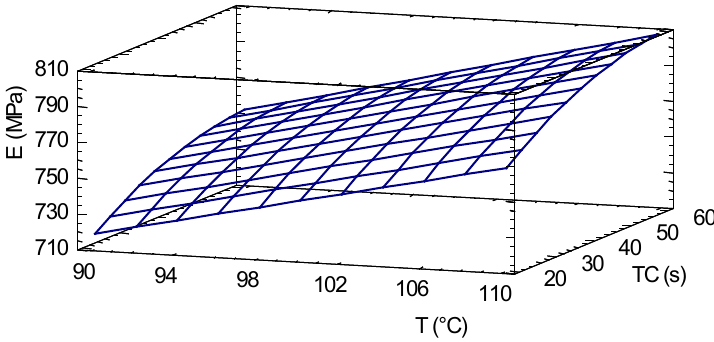
Figure 9. Estimated response surface for the modulus of elasticity considering the process temperature and the compaction time for a rice husk proportion of 50%.